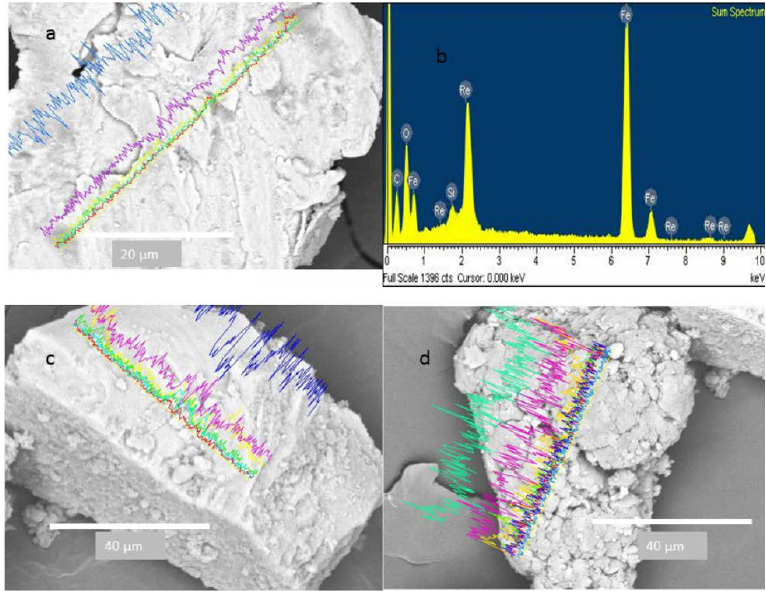
Figure 11. Iron particles with different morphologies. ( a ) Layer; ( b ) EDX spectrum; ( c ) rhomboid and ( d )